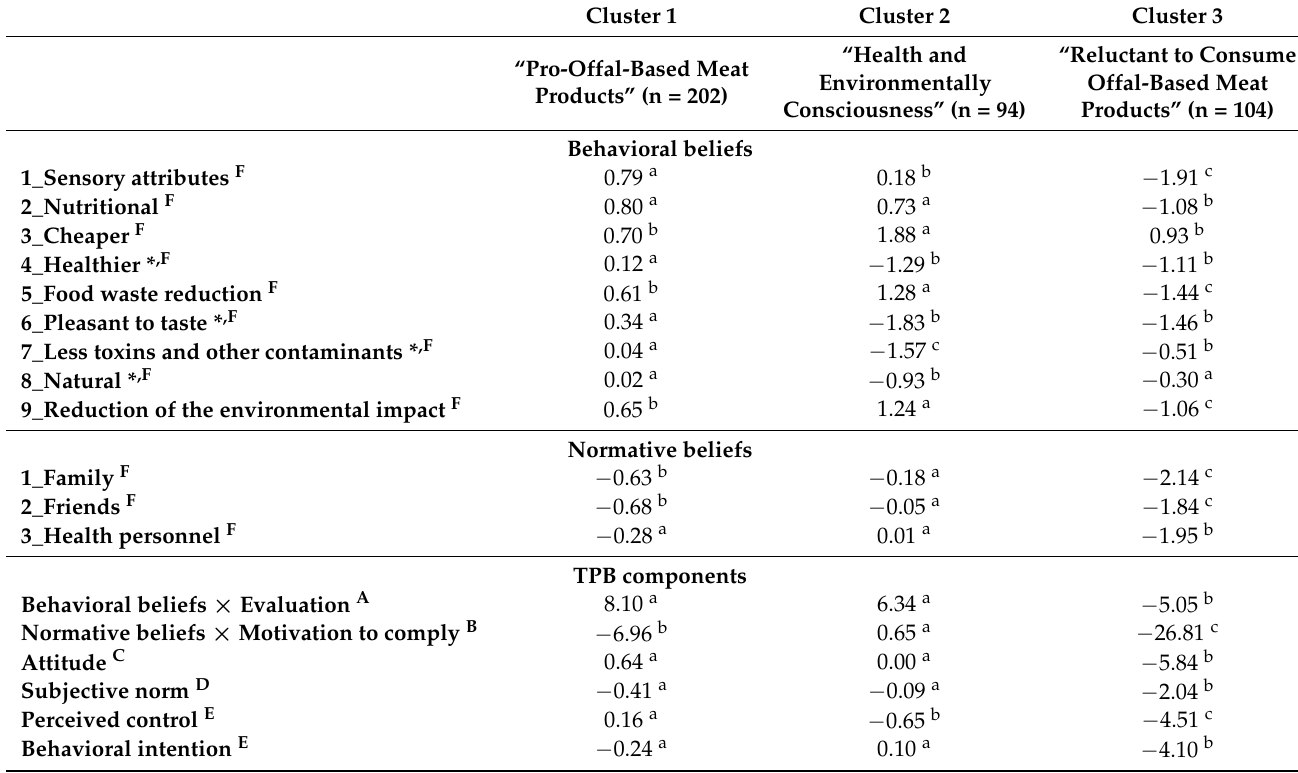
Table 3. Least squared means for the different components of the model by each of the three clusters